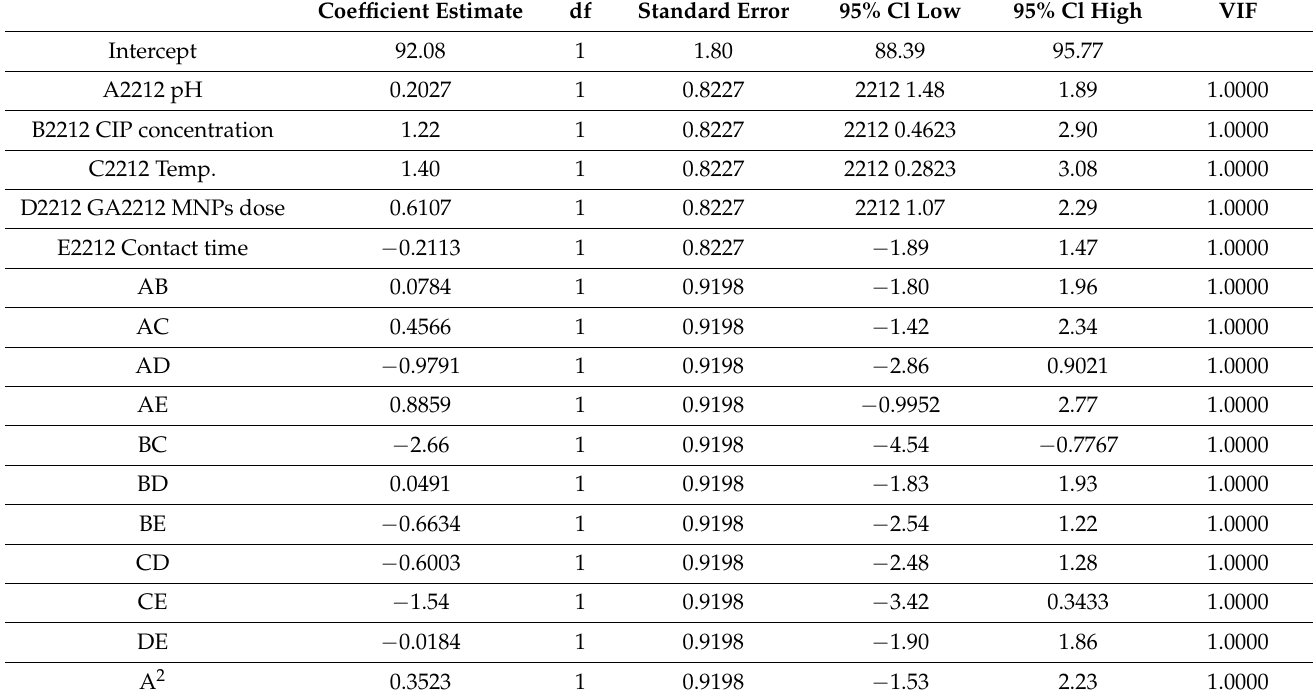
Table 6. Coefficients in terms of coded factors for the responses (CIP